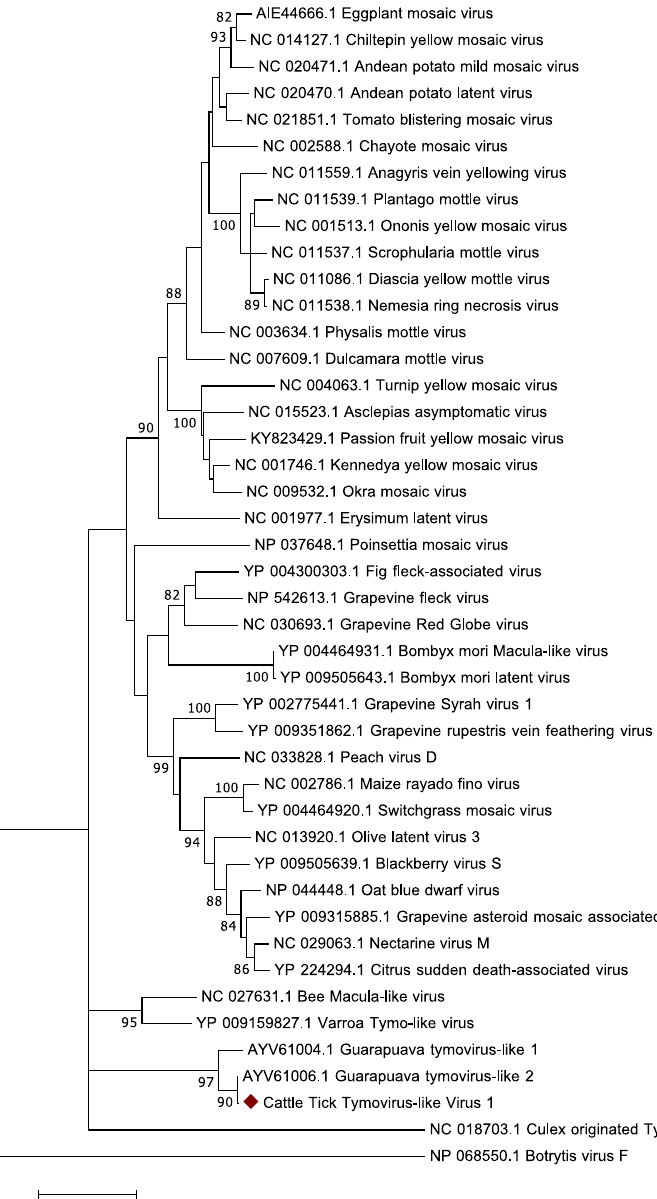
Figure 3. Phylogenetic relationship of Tymovirales based on a 1068-aa alignment of the replicase